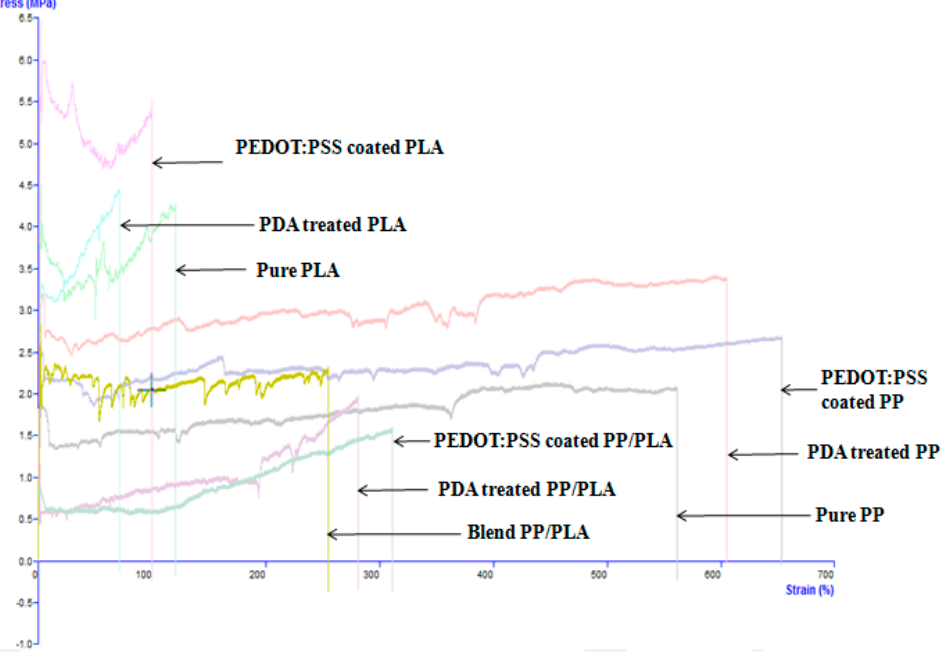
Figure 7. The stress-strain curves of various thermoplastic yarns. Table 3. Mechanical properties of thermoplastic yarns.